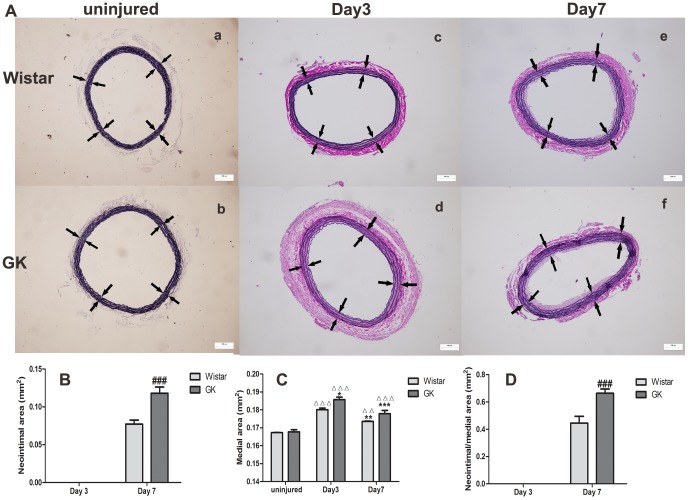
EVG staining of common carotid arteries in Wistar and GK rats (100×).EVG staining of uninjured (A-a, A-b), Day 3 post-injury (A-c, A-d) and Day 7 post-injury (A–e, A–f) in Wistar and GK rats. Neointimal emerged at Day 7 post-injury (B), the media peaked at Day 3 post-injury (C) and N/M ratio in GK rats was higher than that in Wistar rats (D) at Day 7 post-injury. White arrows pointed to the media. Data are represented as mean ± SEM. ΔΔΔindicates versus uninjured, p<0.001; *indicates versus Day 3 post-injury, p<0.05, **p<0.01; #indicates versus Day 7 post-injury, p<0.05, ###p<0.001.